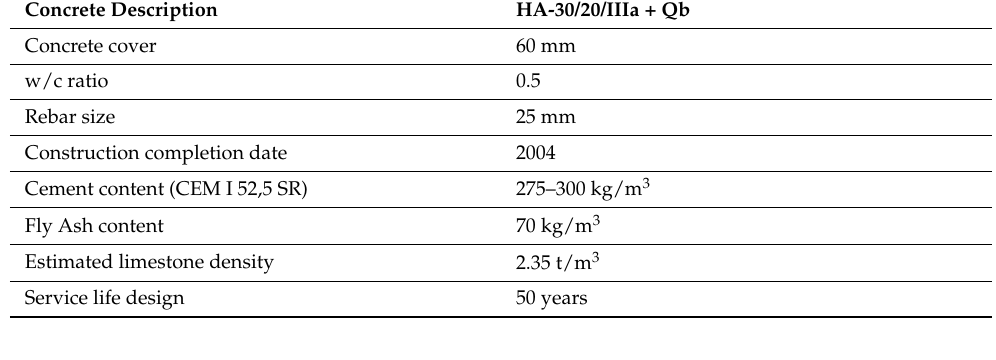
Table 1. Concrete description and Service Life Design.